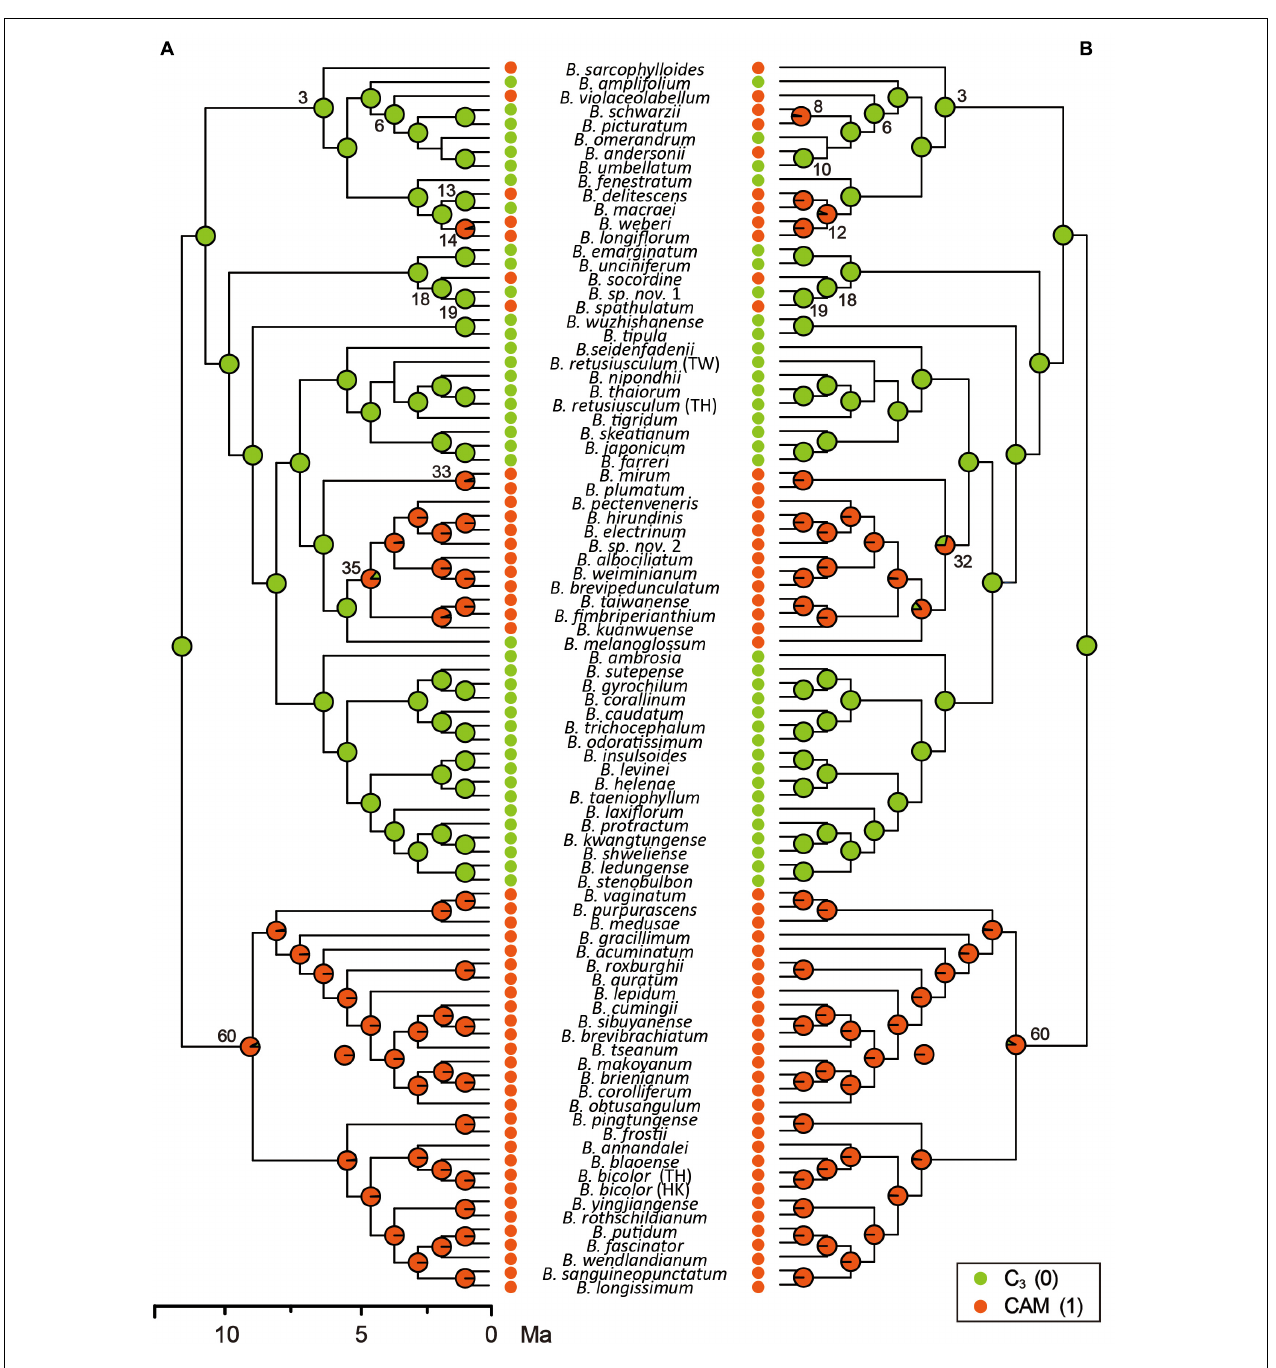
FIGURE 2 | Reconstruction of the evolution of photosynthetic pathways in the Cirrhopetalum alliance clade, based on two coding schemes of photosynthetic modes described in the main text. Panel (A) corresponds to Coding Scheme S1 and panel (B) corresponds to Coding Scheme S2. Pie charts at internal nodes show relative probabilities assigned to each ancestral state. Clade numbers correlate with those shown in Figure 1 and Supplementary Table 4 . Ma, million years